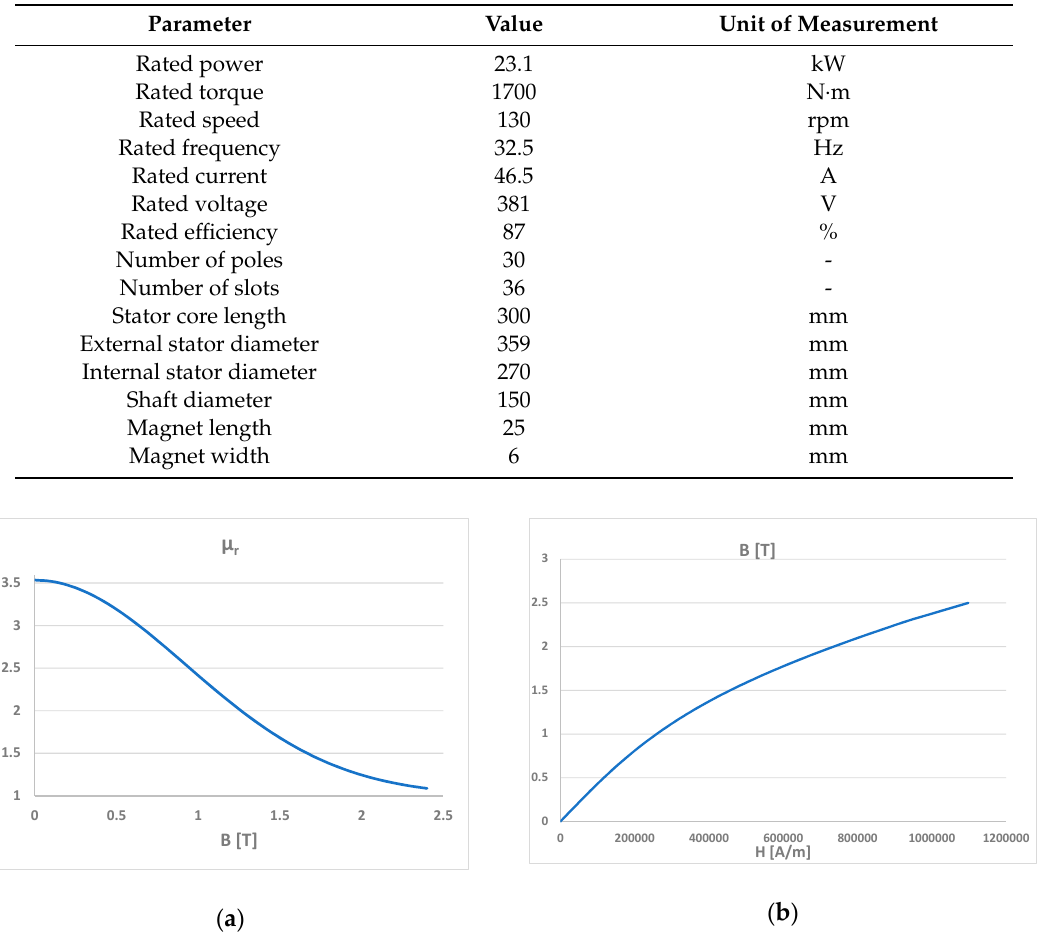
Figure 10. Magnetic wedge characteristics: ( a ) relative permeability; ( b ) magnetization characteristics.